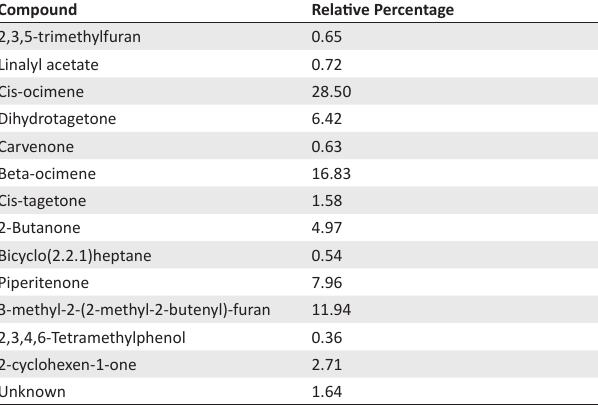
TABLE 1: Constituents of the essential oil of Tagetes minuta and their relative amounts ( % ) according to Gas chromatography-linked mass spectrometry analysis.